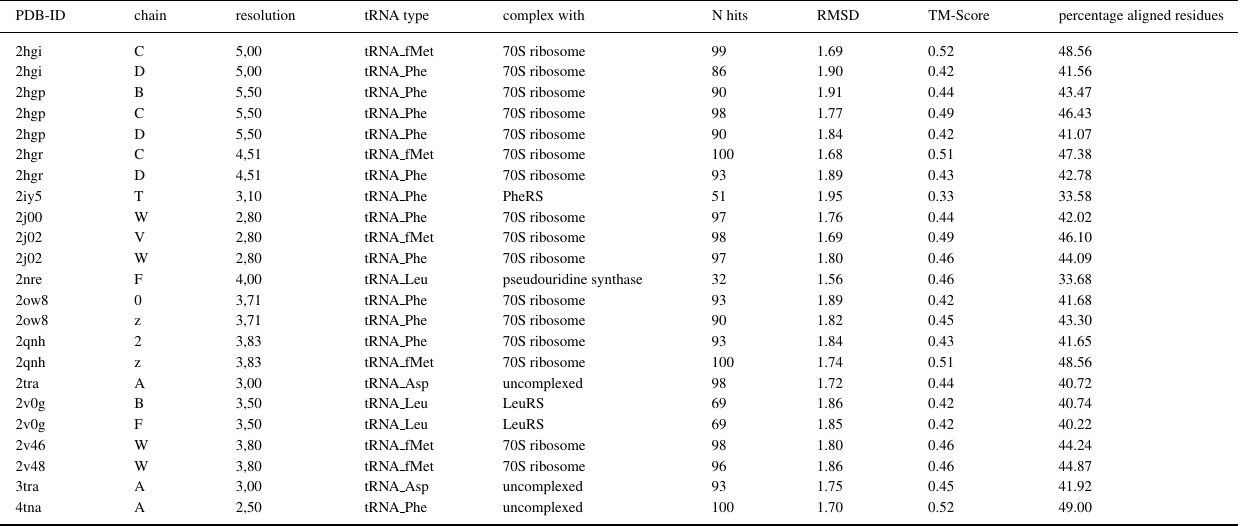
Table 2. tRNA search result table (part